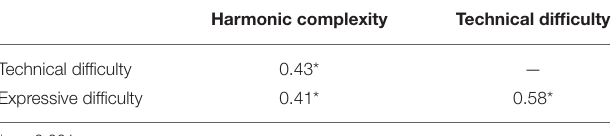
TABLE 2 | Correlations between performers’ rating measures.